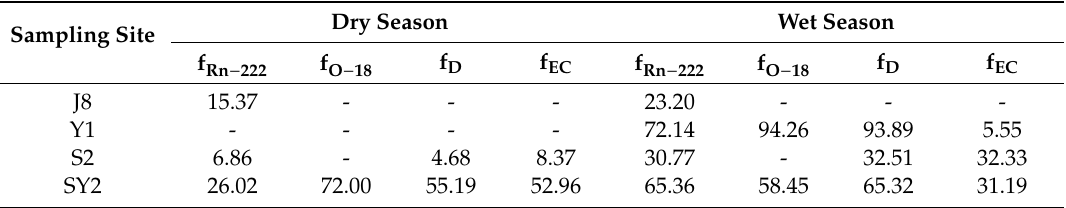
Table 1. The mixing proportions of riparian groundwater in the dry season and wet season. Sampling